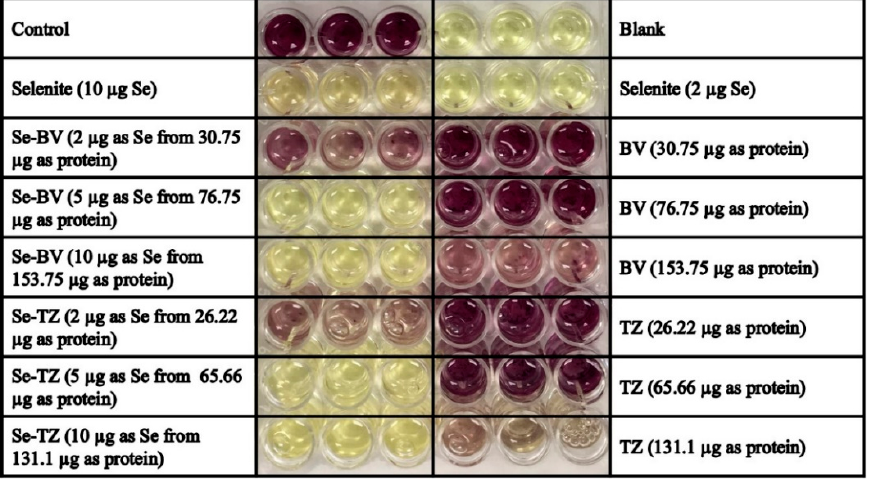
Figure A4. HME50-5E MTT Plate Photo on Day 6 Post Treatment showing the insoluble formazan salt.